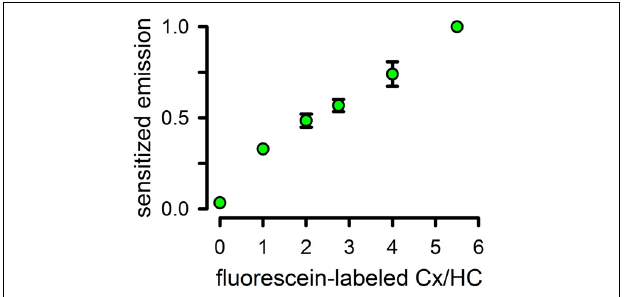
FIGURE 6 | Use of luminescence resonance energy transfer to assay hemichannels subunit composition. Sensitized fluorescence emission as a function of the average number of fluorescein-labeled subunits/HC. Data were normalized to the peak value of 1 Tb/5.5 fluorescein-labeled preparation and are means ± s.e.m. of 7–9 experiments. Reconstitution was at an average of 0.8 HCs/liposome. All values are statistically different from the previous one ( P < 0 . 001), except for that at the 3/3 ratio. Modified from Bao et al., 2007.